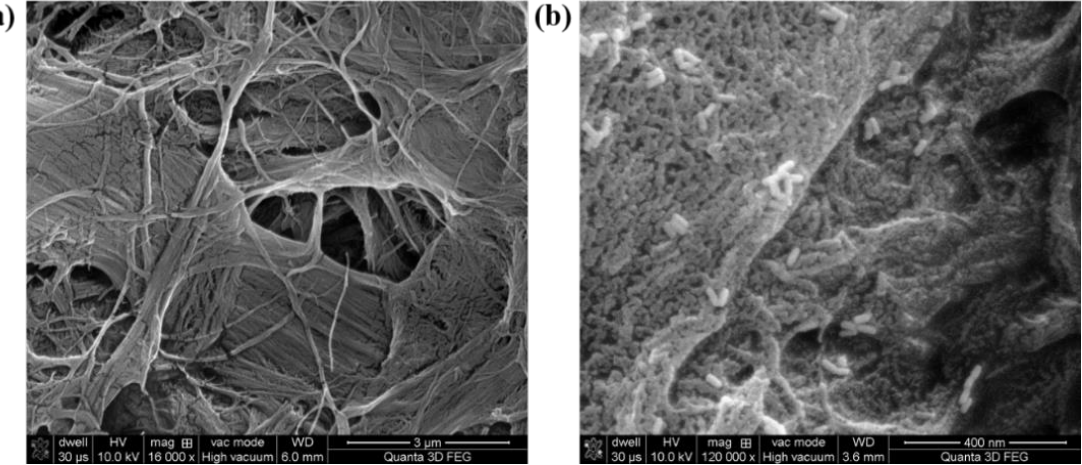
Figure 2. Illustrative SEM images of the bare Whatman filter paper ( a ) before and after the calligra- phy step, using colloidal AuNRs as ink ( b